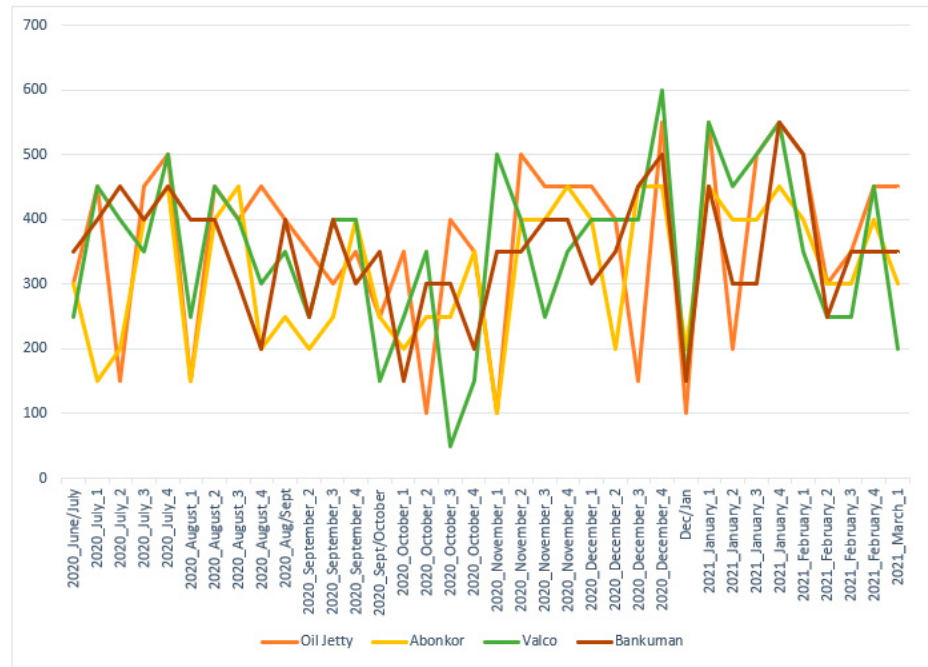
Figure 3. Plot of NO 2 concentration for sampled sites.